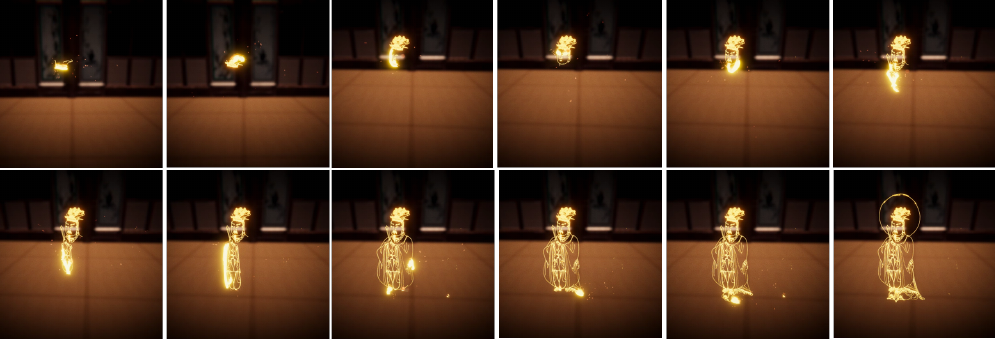
Figure 21. Another example of applications: Virtual